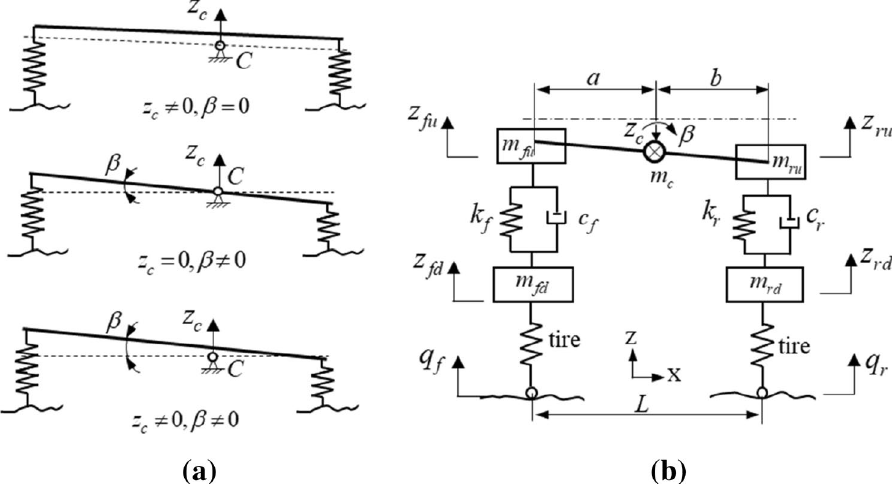
Fig.1 The mechanical model of vehicle. a The vibration forms of the body. b 6-dof 1/2 vehicle mechanics